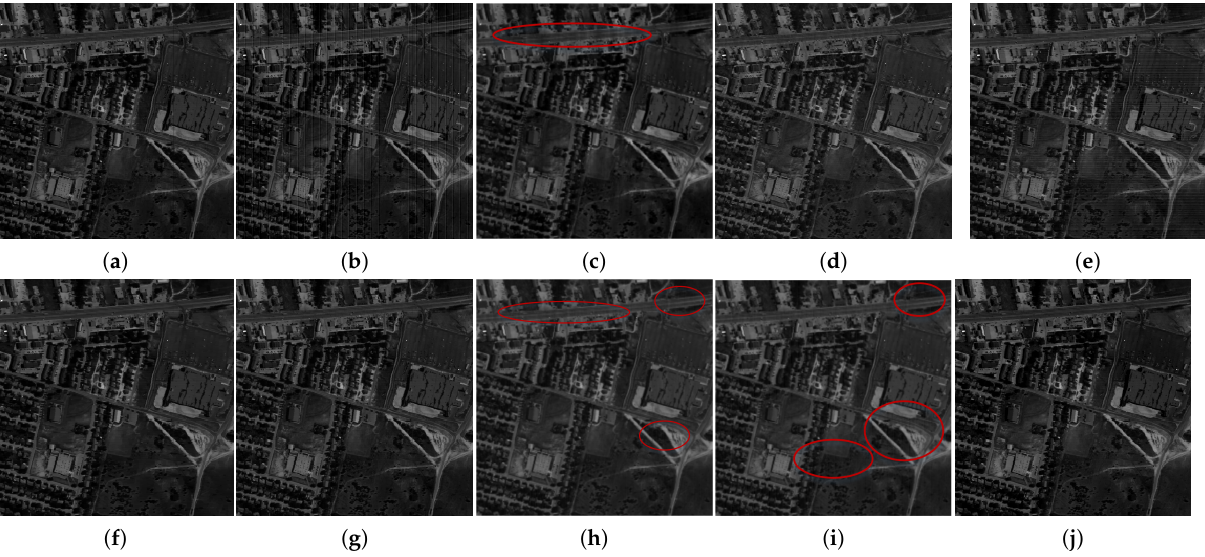
Figure 5. Corrected HYDICE Urban images for band 120. ( a ) Original image. ( b ) Degraded image. Images corrected by ( c ) MM, ( d ) ASSTV, ( e ) LRSID, ( f ) that of reference [43], ( g ) PADMM, ( h ) ICSRN, ( i ) SSGN, ( j )